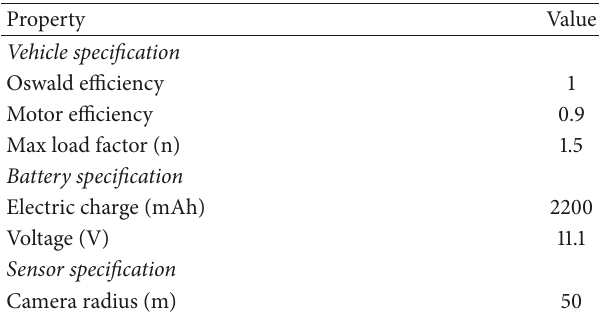
Table 1: Properties of the vehicle for simulation.